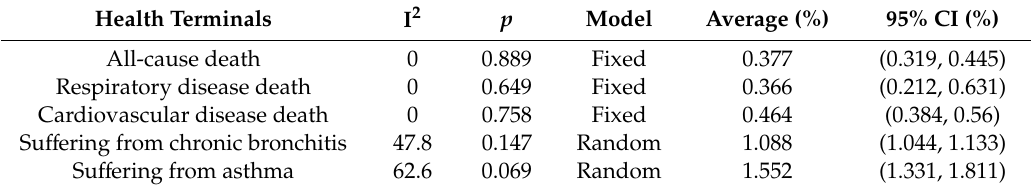
Table 3. Heterogeneity test and meta-analysis